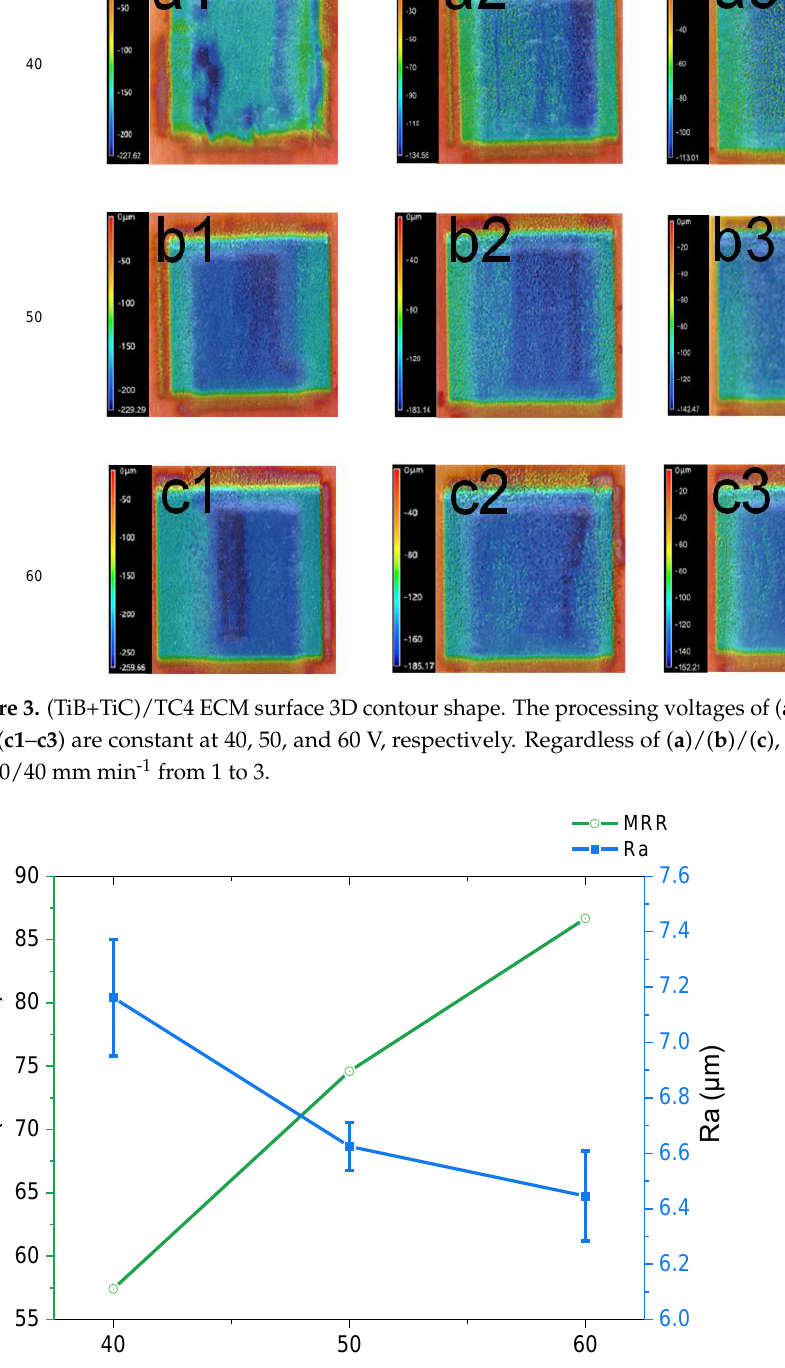
Figure 3. (TiB+TiC)/TC4 ECM surface 3D contour shape. The processing voltages of ( a1 - a3 ), ( b1 - b3 ), and ( c1 - c3 ) are constant at 40, 50, and 60 V, respectively. Regardless of ( a )/( b )/( c ), the feed rate is 20/30/40 mm min -1 from 1 to 3.